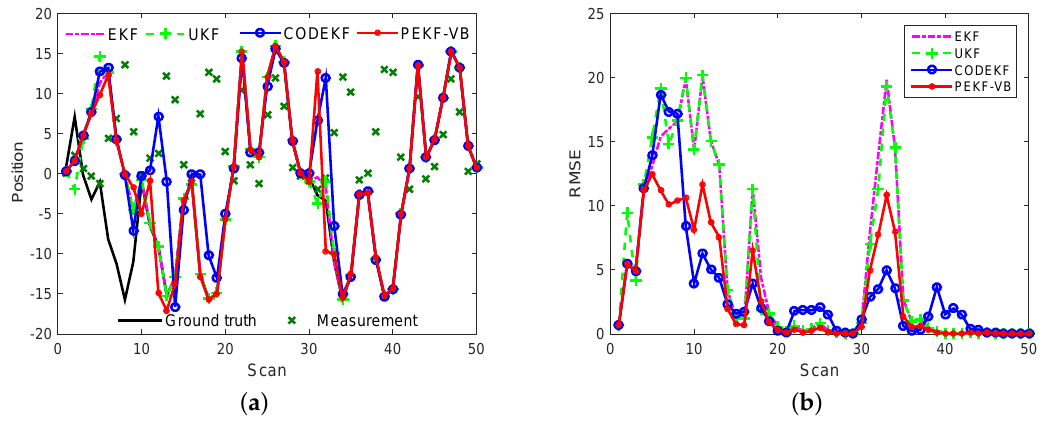
Figure 8. Comparison of EKF, UKF, CODEKF and PEKF-VB ( a ) Filtering results ( b )